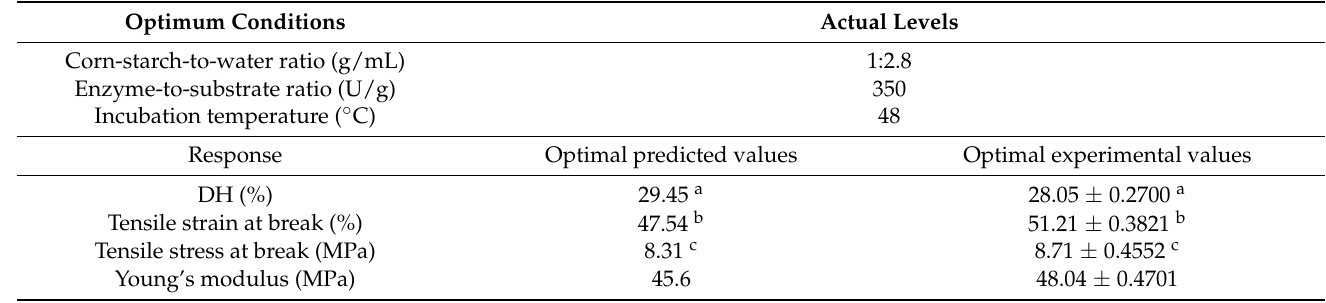
Table 6. Optimum conditions, experimental and predicted values of